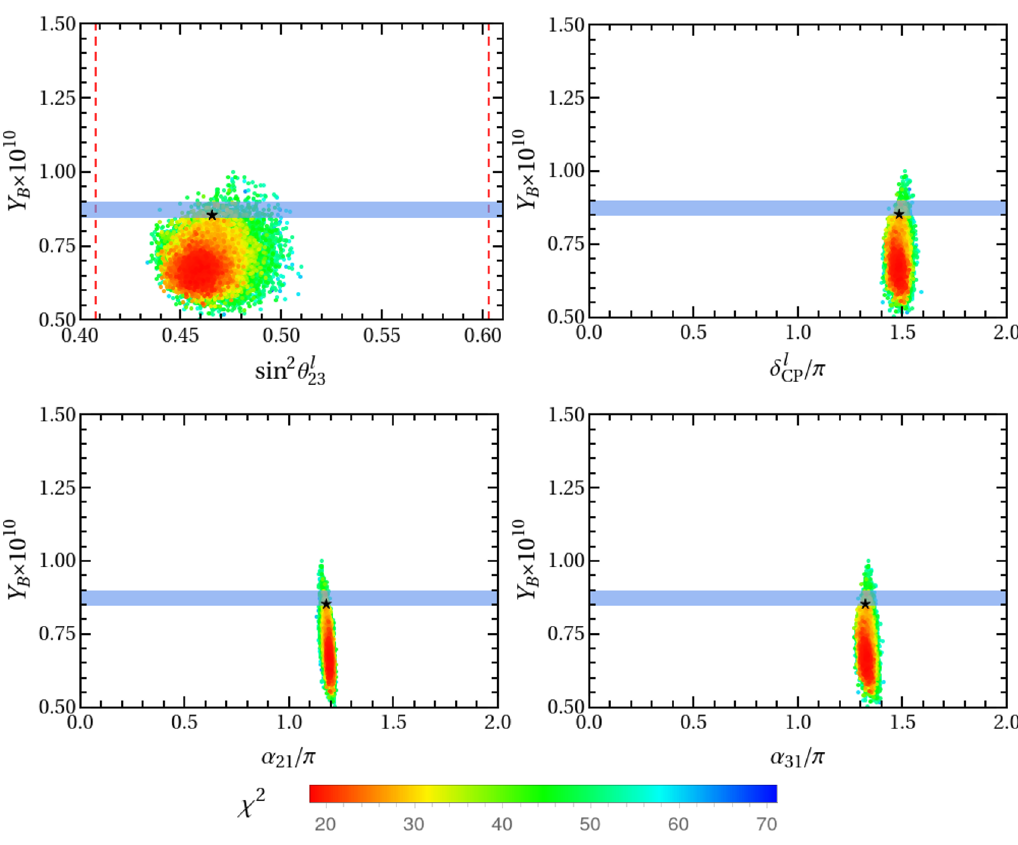
Figure 3 . The numerical results for the correlation between the baryon asymmetry Y B and sin 2 θ l δ l , α 21 , α 31 in the BM1 model with vanishing initial condition. The horizontal band denotes the CP experimentally allowed region of Y B . The star “ F ” stands for the best fitting point in table 3. Note that the contribution of Y B to χ 2 is not included